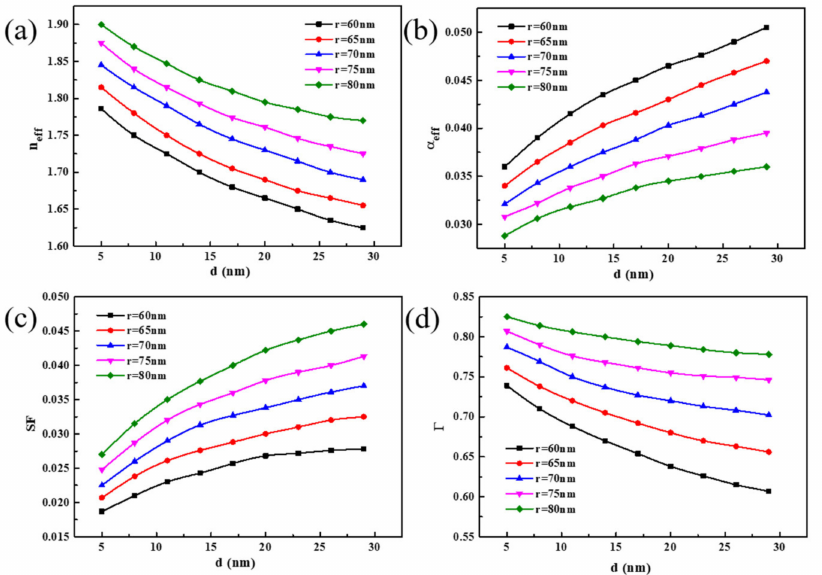
Figure 4. The mode properties change with the nanowire radius r and dielectric layer thickness d . ( a ) The effective index n eff , ( b ) the effective propagation loss α eff , ( c ) the normalized model area SF and ( d ) the confinement factor Γ .